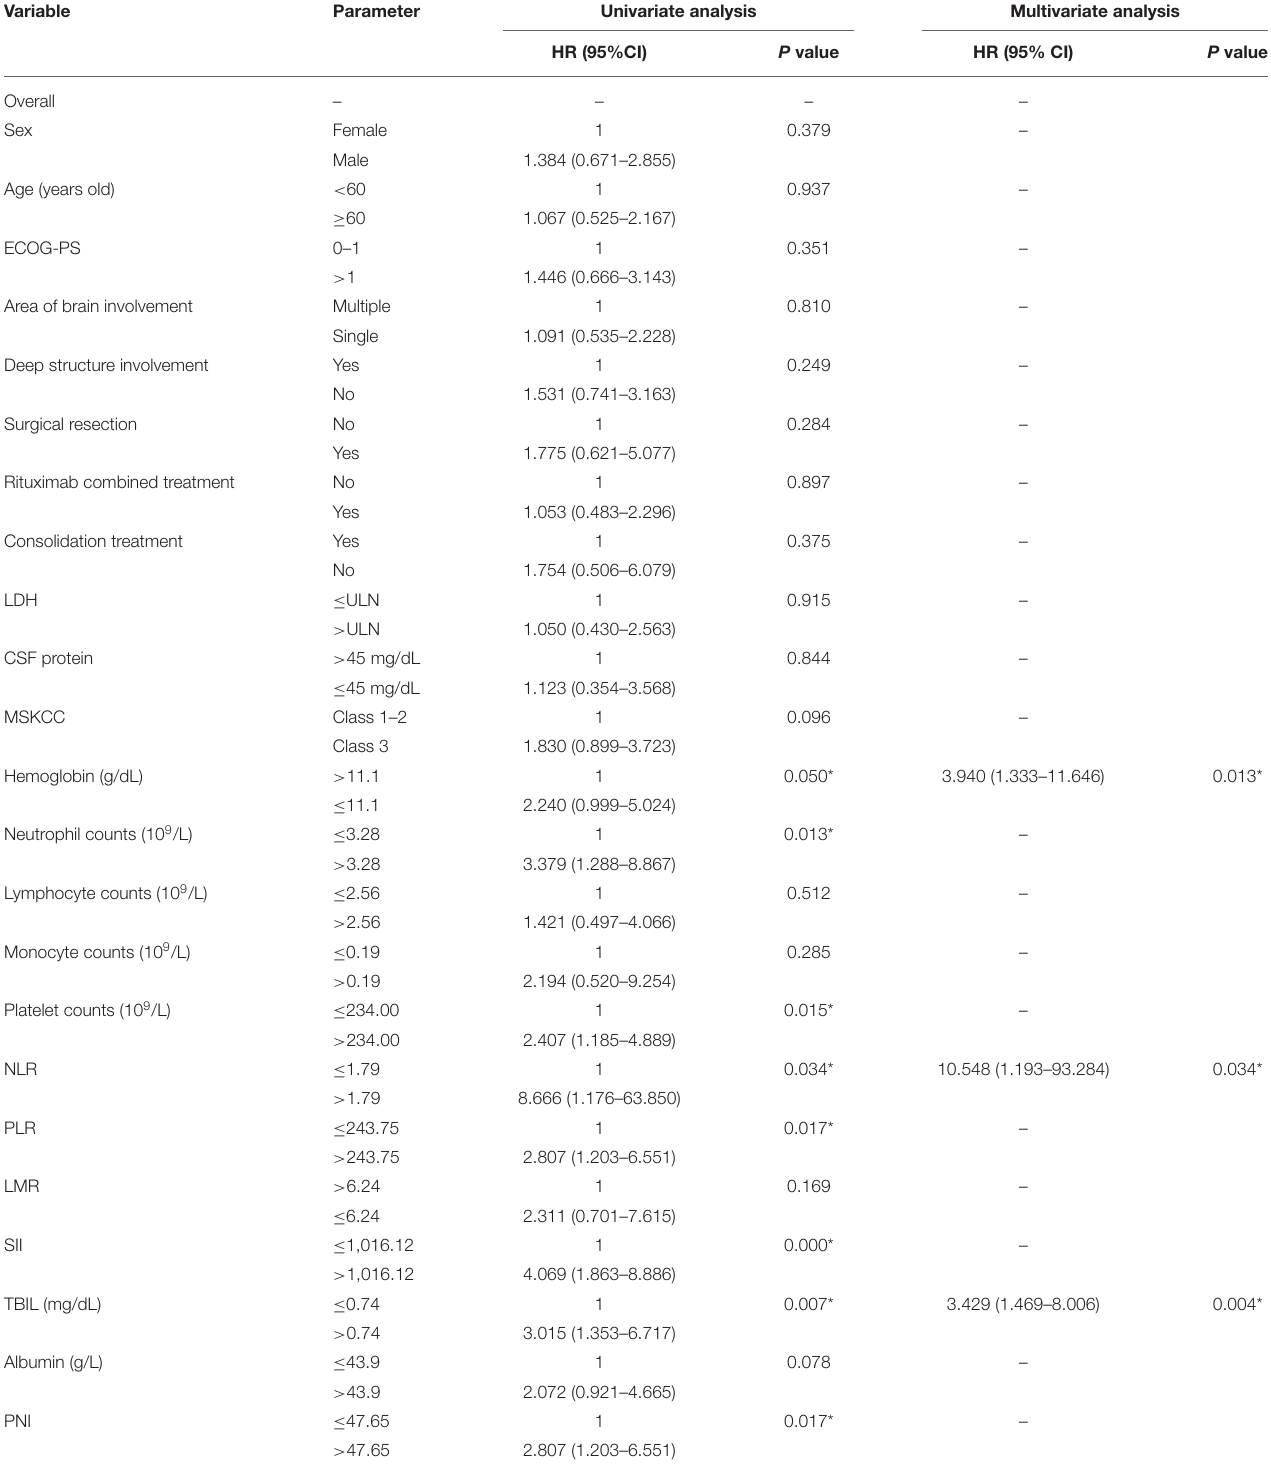
TABLE 3 | Univariate and multivariate analysis of